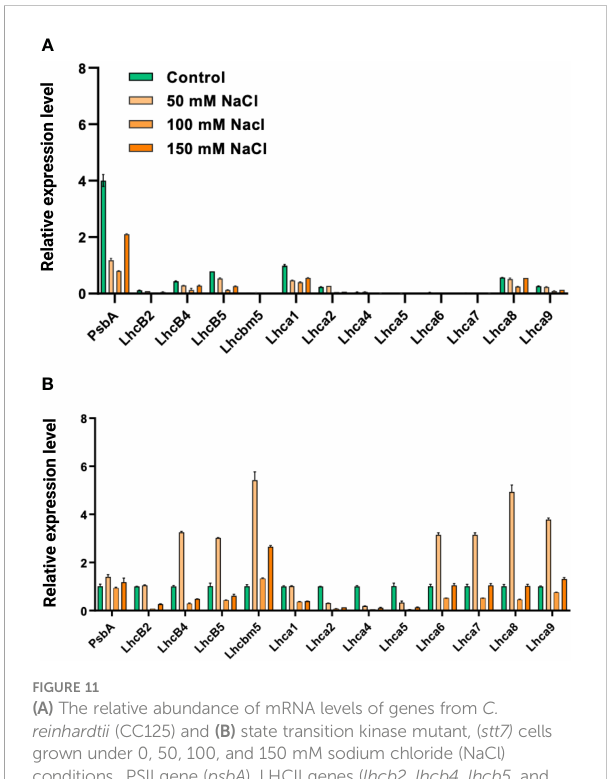
FIGURE 11 (A) The relative abundance of mRNA levels of genes from C. reinhardtii (CC125) and (B) state transition kinase mutant, ( stt7) cells grown under 0, 50, 100, and 150 mM sodium chloride (NaCl) conditions., PSII gene ( psbA ), LHCII genes ( lhcb2, lhcb4, lhcb5 , and lhcbm5 ) and LHCI genes, ( lhca1 , lhca2 , lhca4 , lhca5 , lhca6 , lhca7 , lhca8 , and lhca9) were monitored under same salt stress condition. All the genes were normalized with the housekeeping gene, Histone